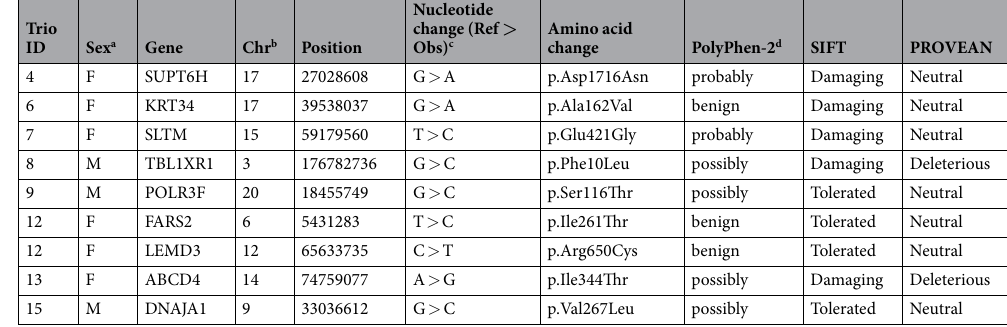
Table 1. De novo non-synonymous missense mutations. Using hg19 as the human reference genome. a Sex; M = Male, F = Female. b Chr = Chromosome. c Ref = reference genome sequence, Obs = observed geneme sequence. d PolyPhen-2; probably = probably damaging, possibly = possibly damaging. Degree of damaging “probably” > “possibly” >